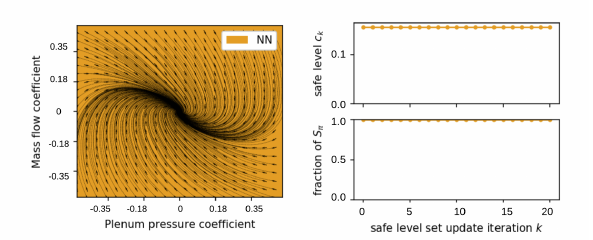
Figure 4: (a) Safe NN Lyapunov candidate level sets